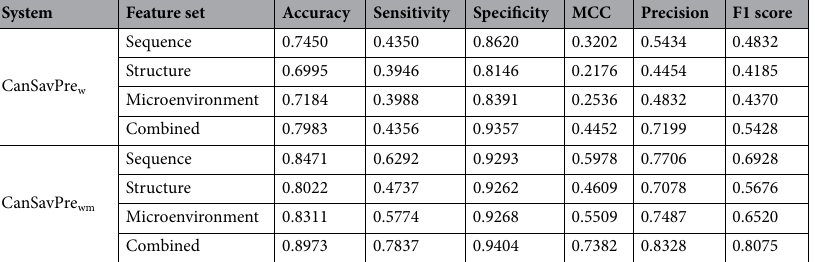
Table 5. Comparisons of the five-fold cross-validation performance values in the training set of two prediction systems based on three feature sets, combined by second-layer SVM. All predictions were optimized using MCC as the fitness